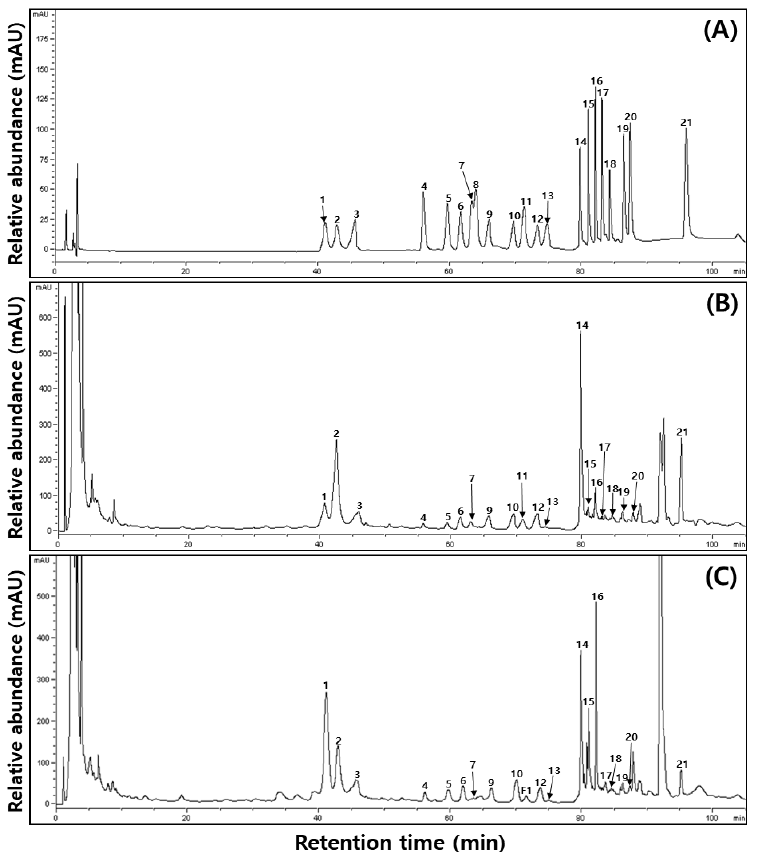
Figure 1. The typical HPLC chromatogram of PGS in different cultivation systems in a plant factory: (A) 21 ginsenoside standards; (B) soil–substrate cultivation; (C) deep-water cultivation. (1) Ginseno- side Rg1, (2) Re, (3) Ro, (4) Rf, (5) F5, (6) F3, (7) Rg2, (8) Rh1, (9) Rb1, (10) Rc, (11) F1, (12) Rb2, (13) Rb3, (14) Rd, (15) Rd2, (16) F2, (17) Rg3, (18) PPT, (19) Compound K, (20) Rh2, and (21) PPD.